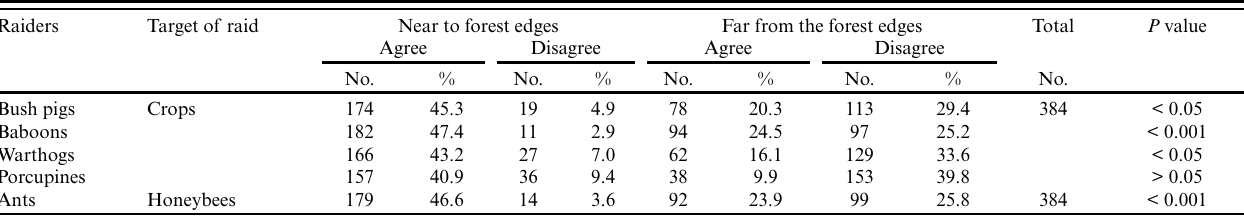
honeybees Table 6. Farmers’ responses regarding the types of crop and honeybee raiders along the transects near to and far from forests. P values are from chi-square tests.